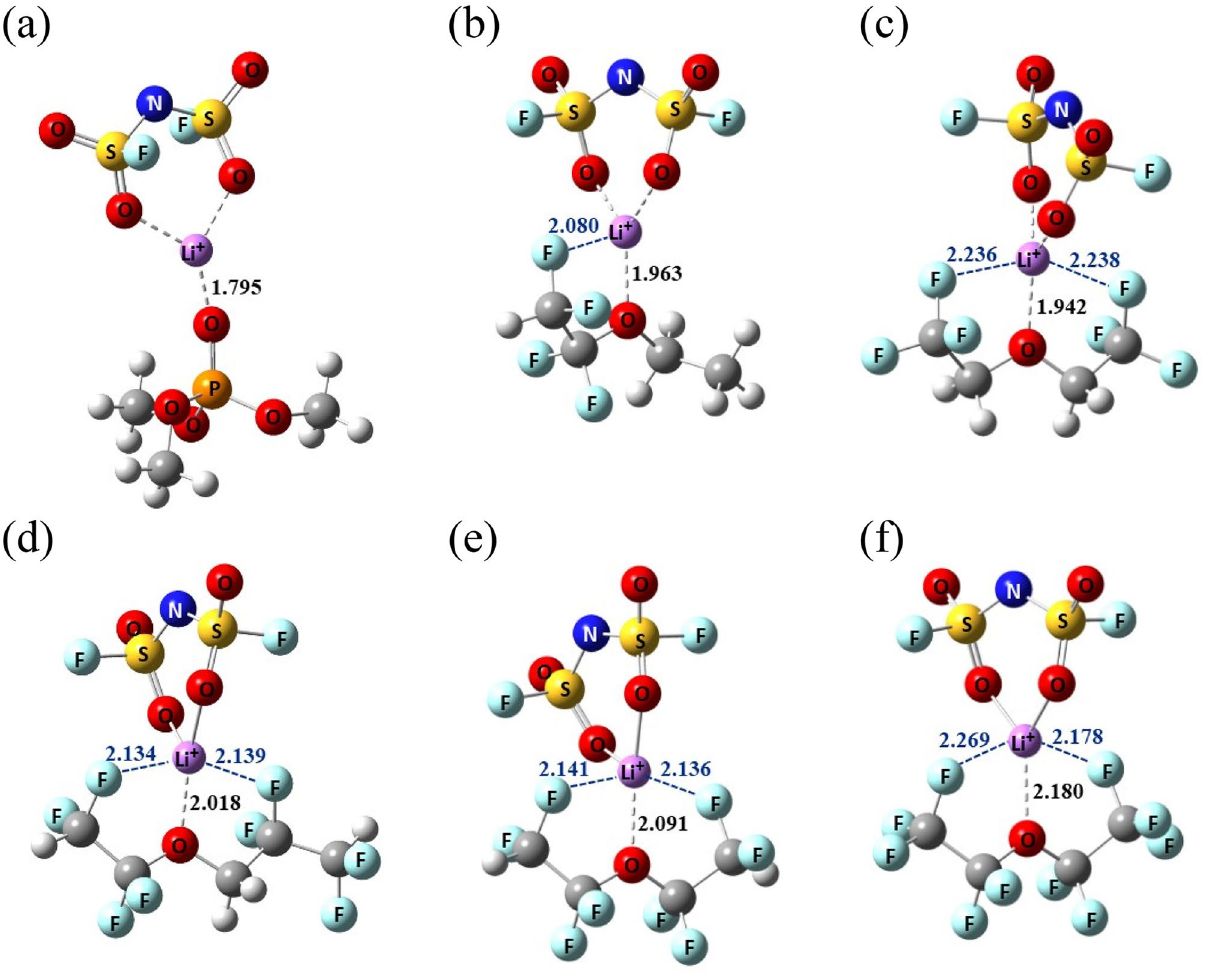
Figure 4. The optimized structure of ( a ) LiFSA-TMP, ( b ) LiFSA-ETE, ( c ) LiFSA-BTFE, ( d ) LiFSA-TTE, ( e ) LiFSA-B2E and ( f ) LiFSA-BPE obtained at M06-2X/def2-TZVP level in TMP ( ε = 20.6) solvent. The selected distances are shown in